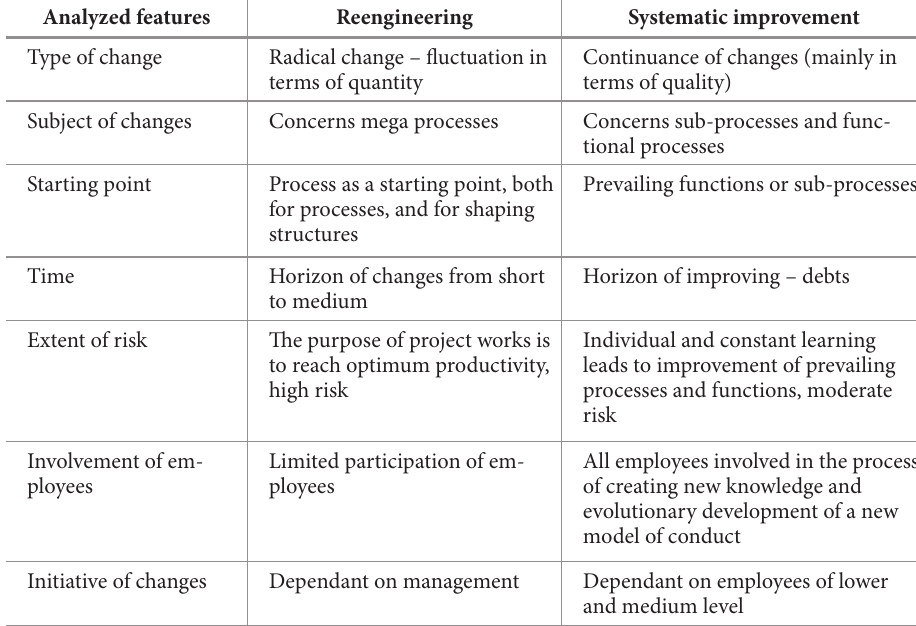
Table 2. Radical and evolutionary approach to changes in a company Analyzed